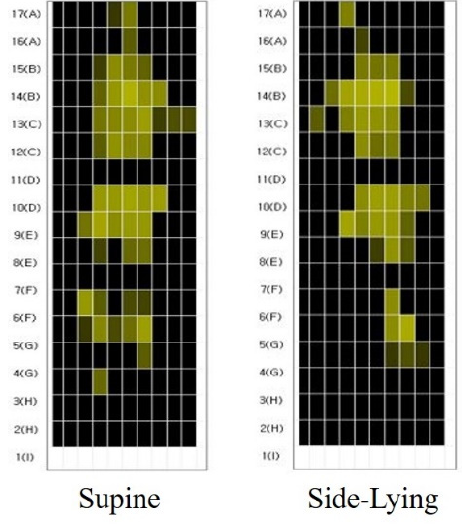
Figure 12. Two body postures considered in the experiments.